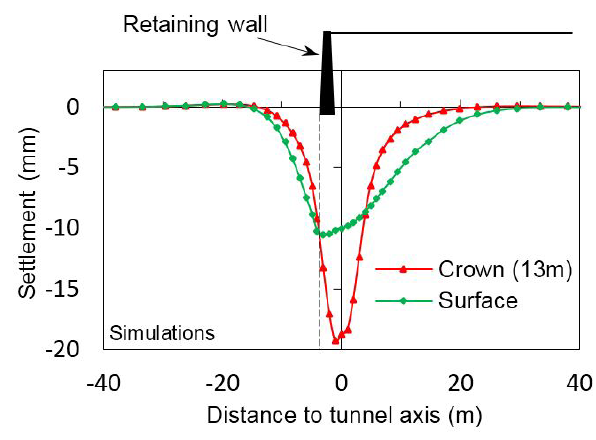
Figure 13: Transverse settlement troughs.